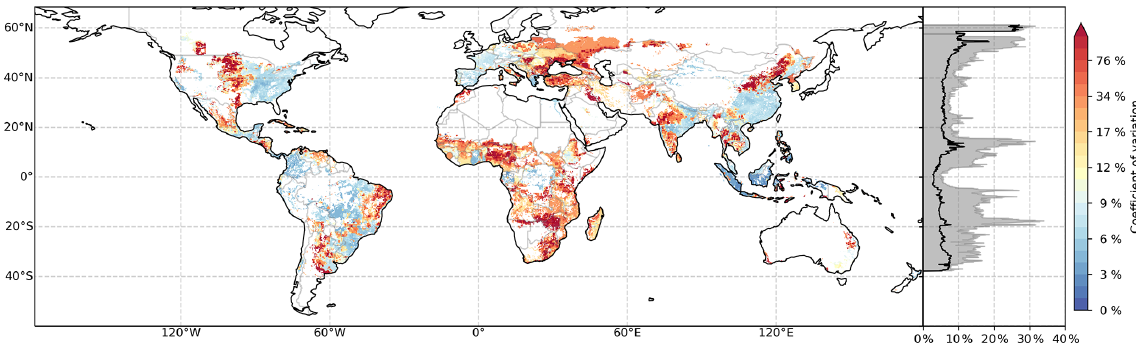
Figure 10. Coefficient of variation of the detrended unit water footprints of maize during 1986–2016 at 5 × 5arcmin resolution. The grey area in the side chart represents the median of all data points along the respective latitude, and the black line is the 10th percentile. Table 3. Comparison of ACEA results for maize with other global gridded studies. Numbers in brackets indicate the difference compared to the results of